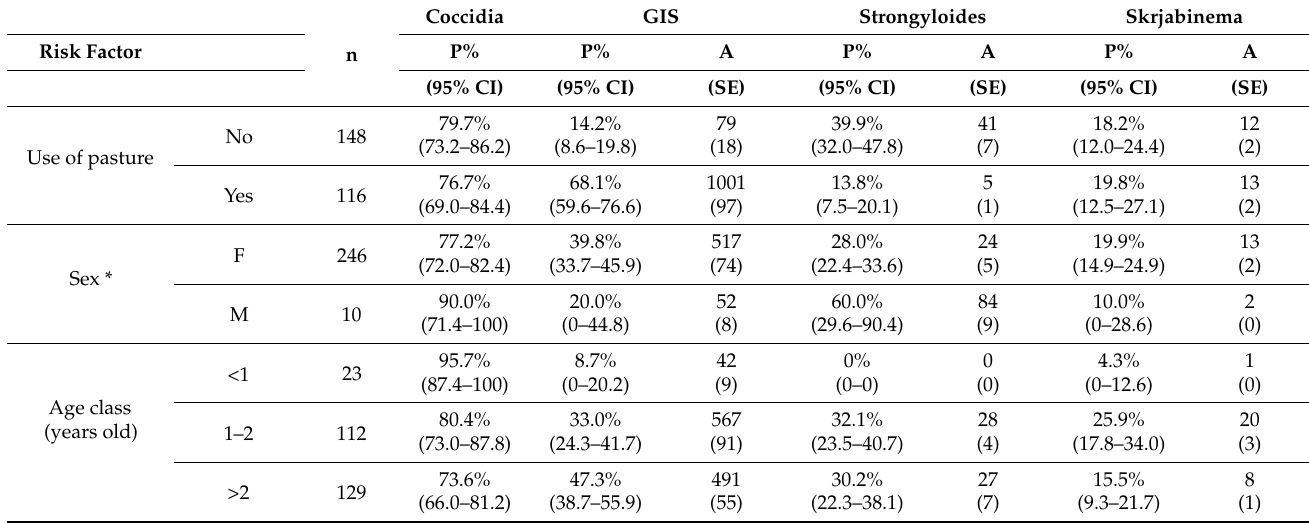
Table 2. Prevalence and abundance of coccidia, GIS, Strongyloides and Skrjabinema in different groups, according to sex, age and use of